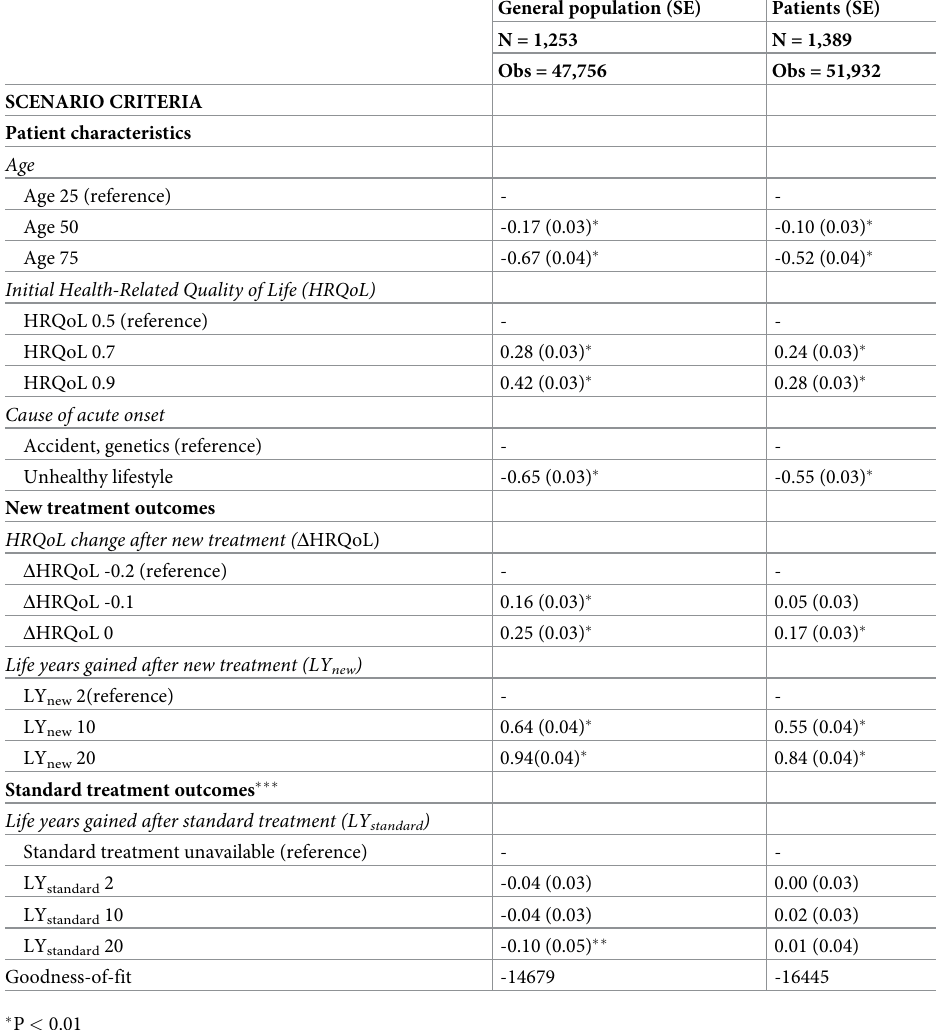
Table 3. Parameter estimates (clogit) of the six criteria for the two sub-samples (based on completed surveys). General population (SE) Patients